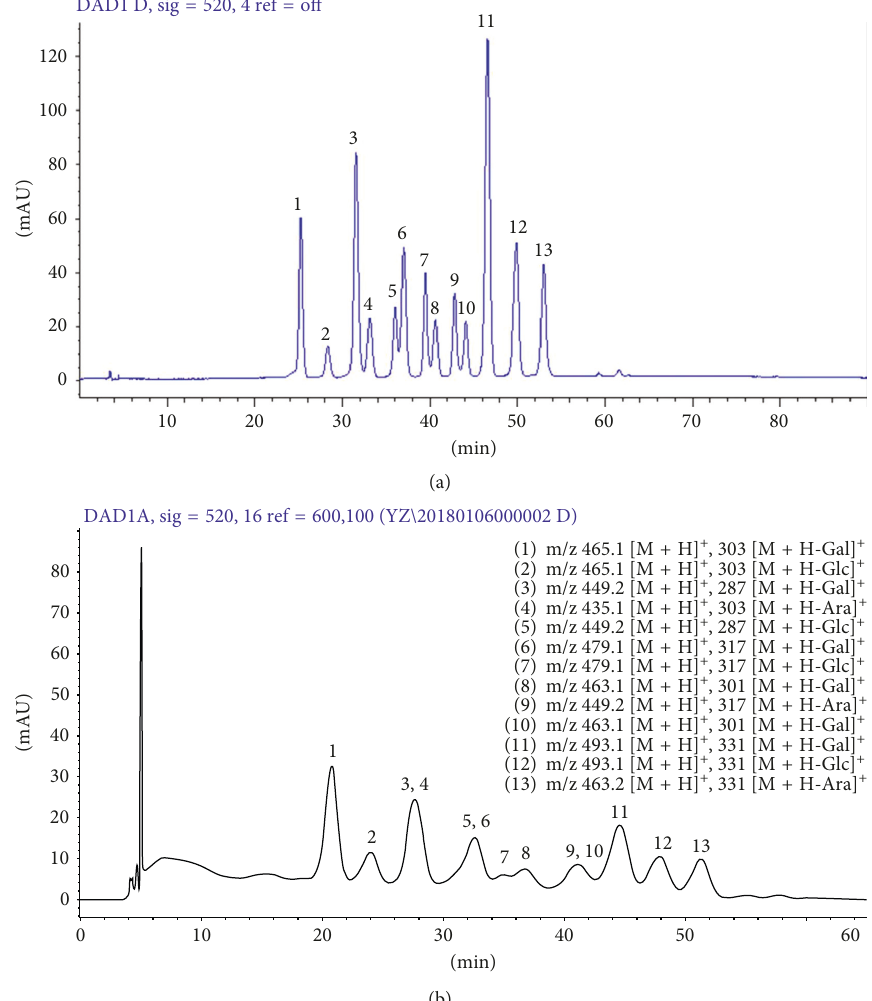
Figure 3: Chromatographic separation ( λ � 520nm) of the anthocyanin extracts of rabbiteye blueberry fruits by (a) HPLC and (b)